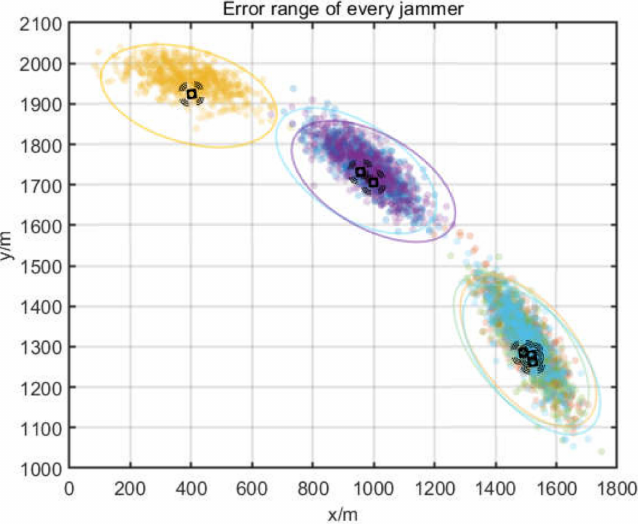
Figure 8. Range of the real locations of the